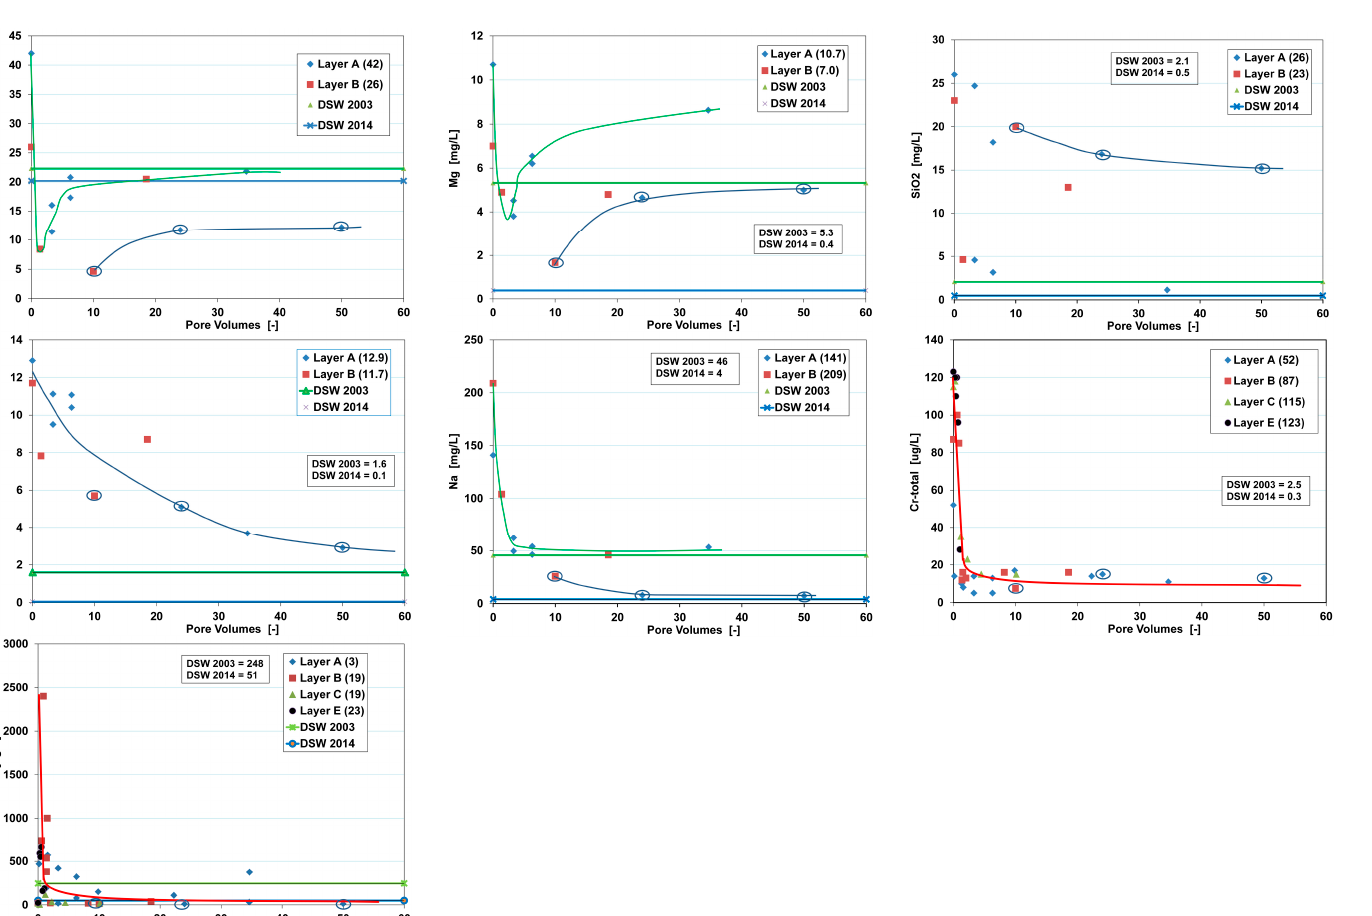
Figure 9. Concentration of selected constituents during and long after breakthrough of DSW in aquifer layers A, B, C and E in the pilot basin recharge scheme, with best fitting lines for all data points or for the data of 2003–2004 and 2014, separately. Mean concentrations in DSW in 2003 and 2014 and in native groundwater of the 2–4 aquifer layers (in legend, within brackets) are indicated. The three encircled observation points in the plot were sampled in August 2014 (after six-year storage), the others were sampled in 2003–2004. Note that samples with >3 pore volumes consist of 100% DSW!